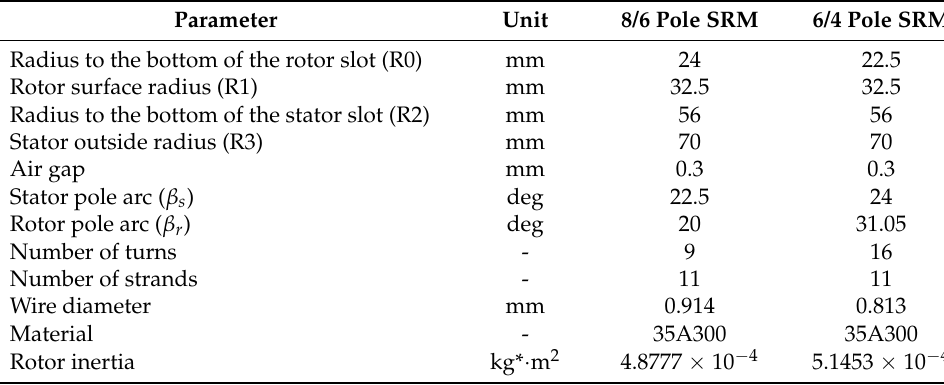
Figure 3. Outline of the designed motor: ( a ) four-phase 8/6 pole SRM; ( b ) three-phase 6/4 pole SRM. Table 3. Calculated parameter of each motor.